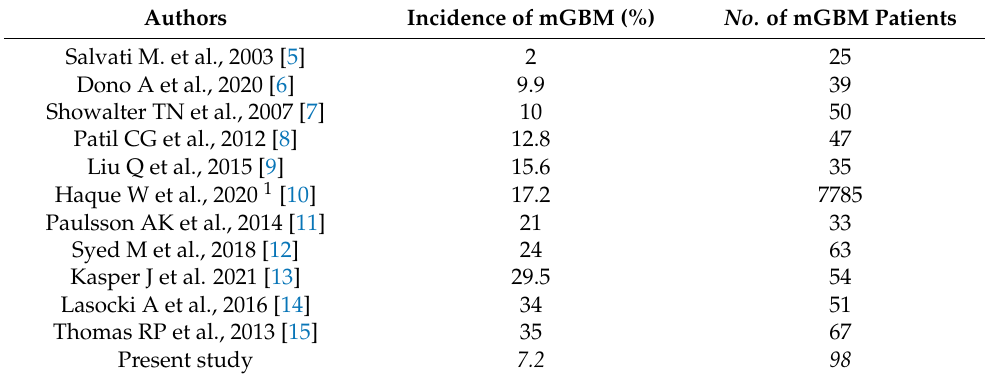
Table 5. Incidence of